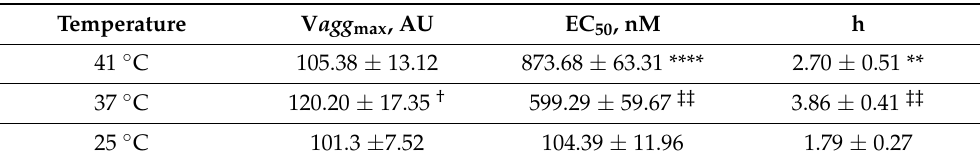
Table 2. Calculated values of the maximal velocity of platelet aggregation (V agg max ), EC 50 , and Hill coefficient (h) at 25 ◦ C, 37 ◦ C, and 41 ◦ C.